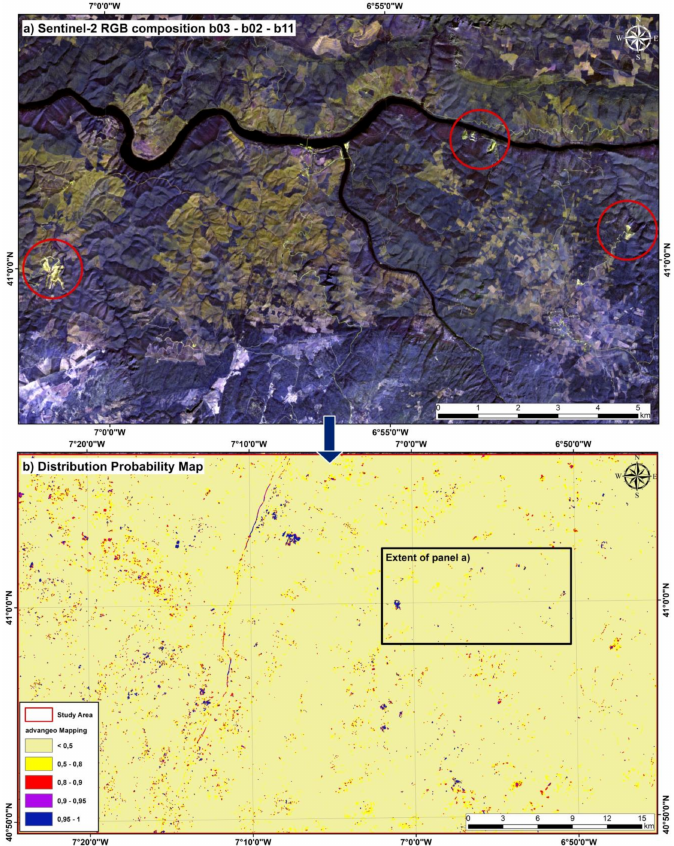
Figure 6. Results of Remote Sensing Model 1: ( a ) RGB composition detail using the super-resolved bands b3–b2–b11 in which mines with known Li mineralisation patterns are shown in light yellow, ( b ) Distribution probability map of Remote Sensing Model